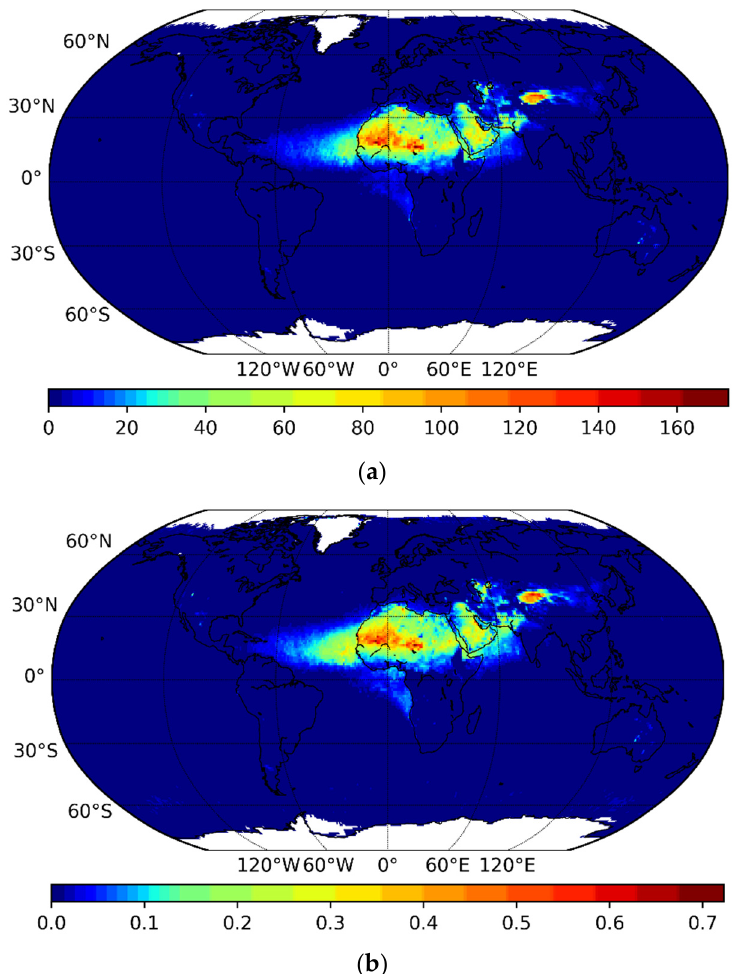
Figure 3. Global distribution of: ( a ) absolute frequency of occurrence of dust aerosols (in number of days/year); ( b ) relative percentage frequency of occurrence of dust aerosols (with respect to the number of days per year with available satellite data and for which the satellite algorithm operated). The results are averaged over the period of 2005–2019. The white-shaded areas are those for which the algorithm did not operate due to missing input data (non-operating algorithm).